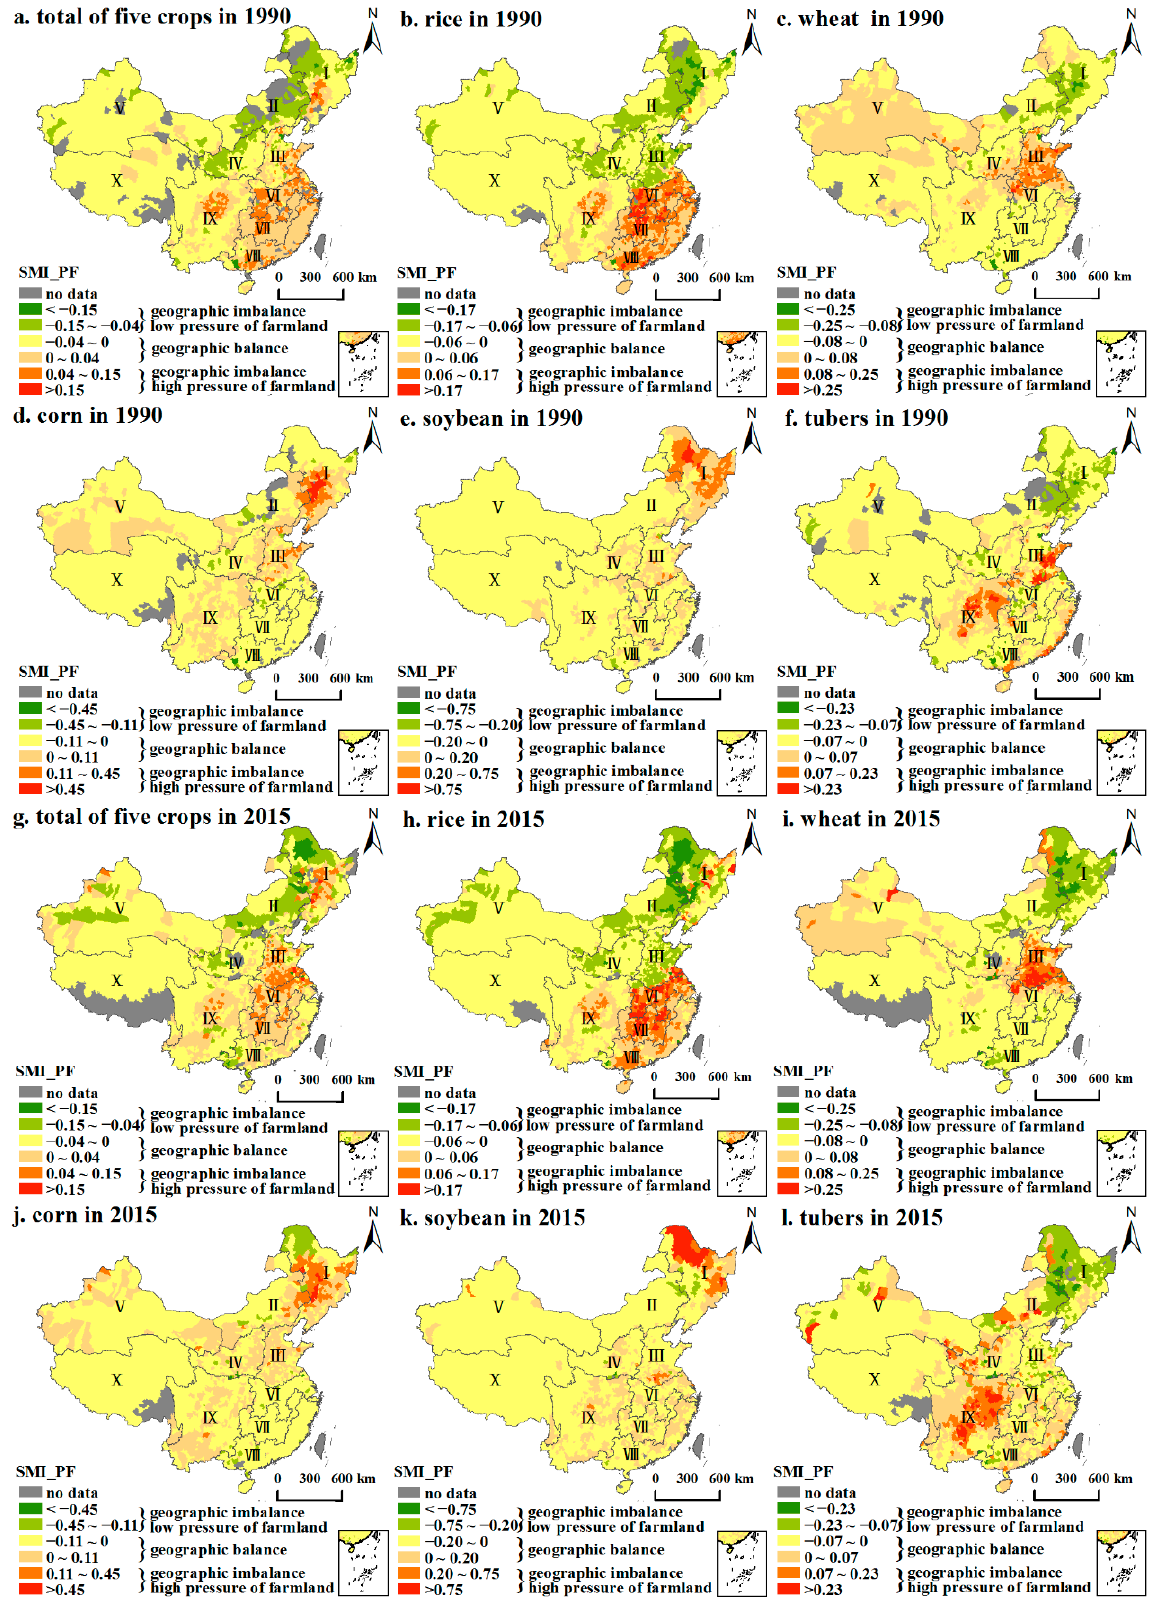
Figure 6. Geographic imbalances between crop production and farmland resources in the period 1990–2015.